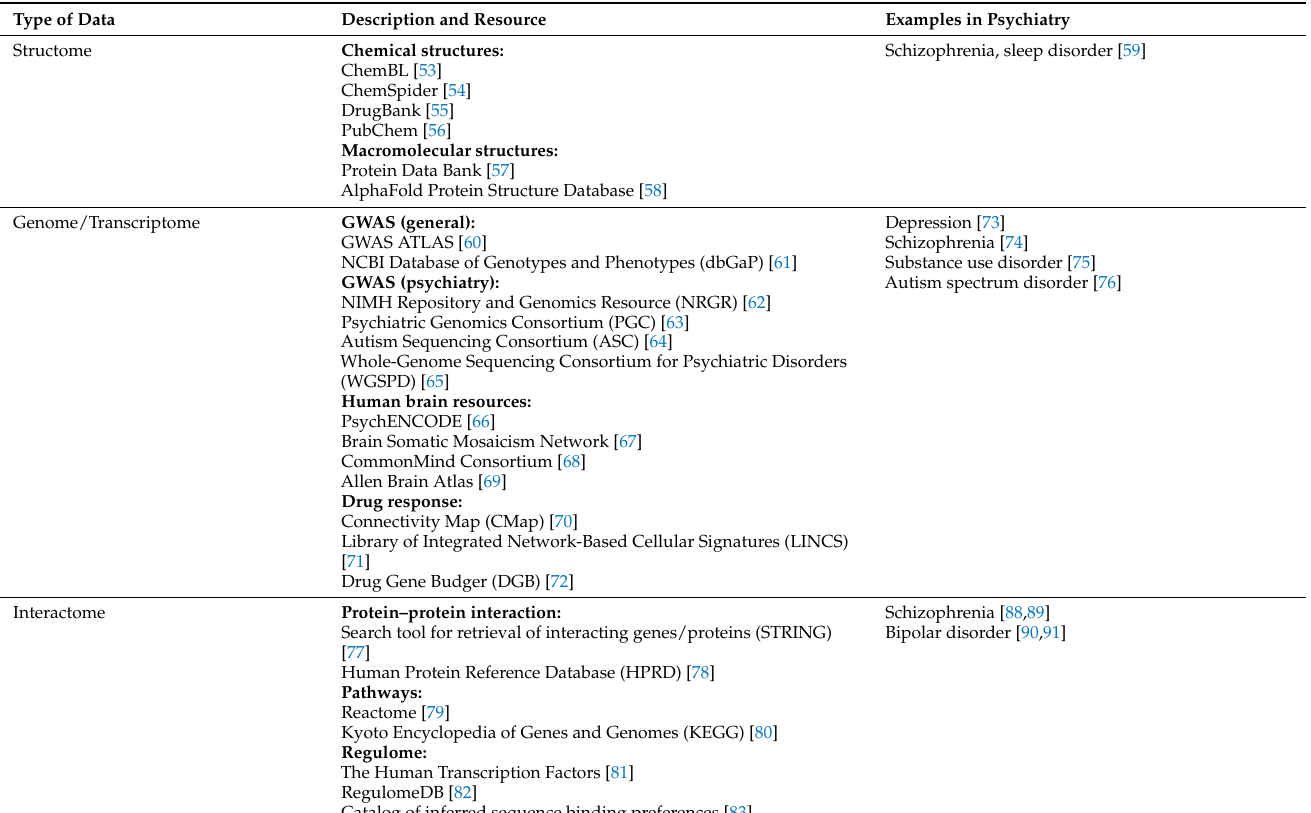
Table 1. Summary of major data sources and their usage examples in psychiatry